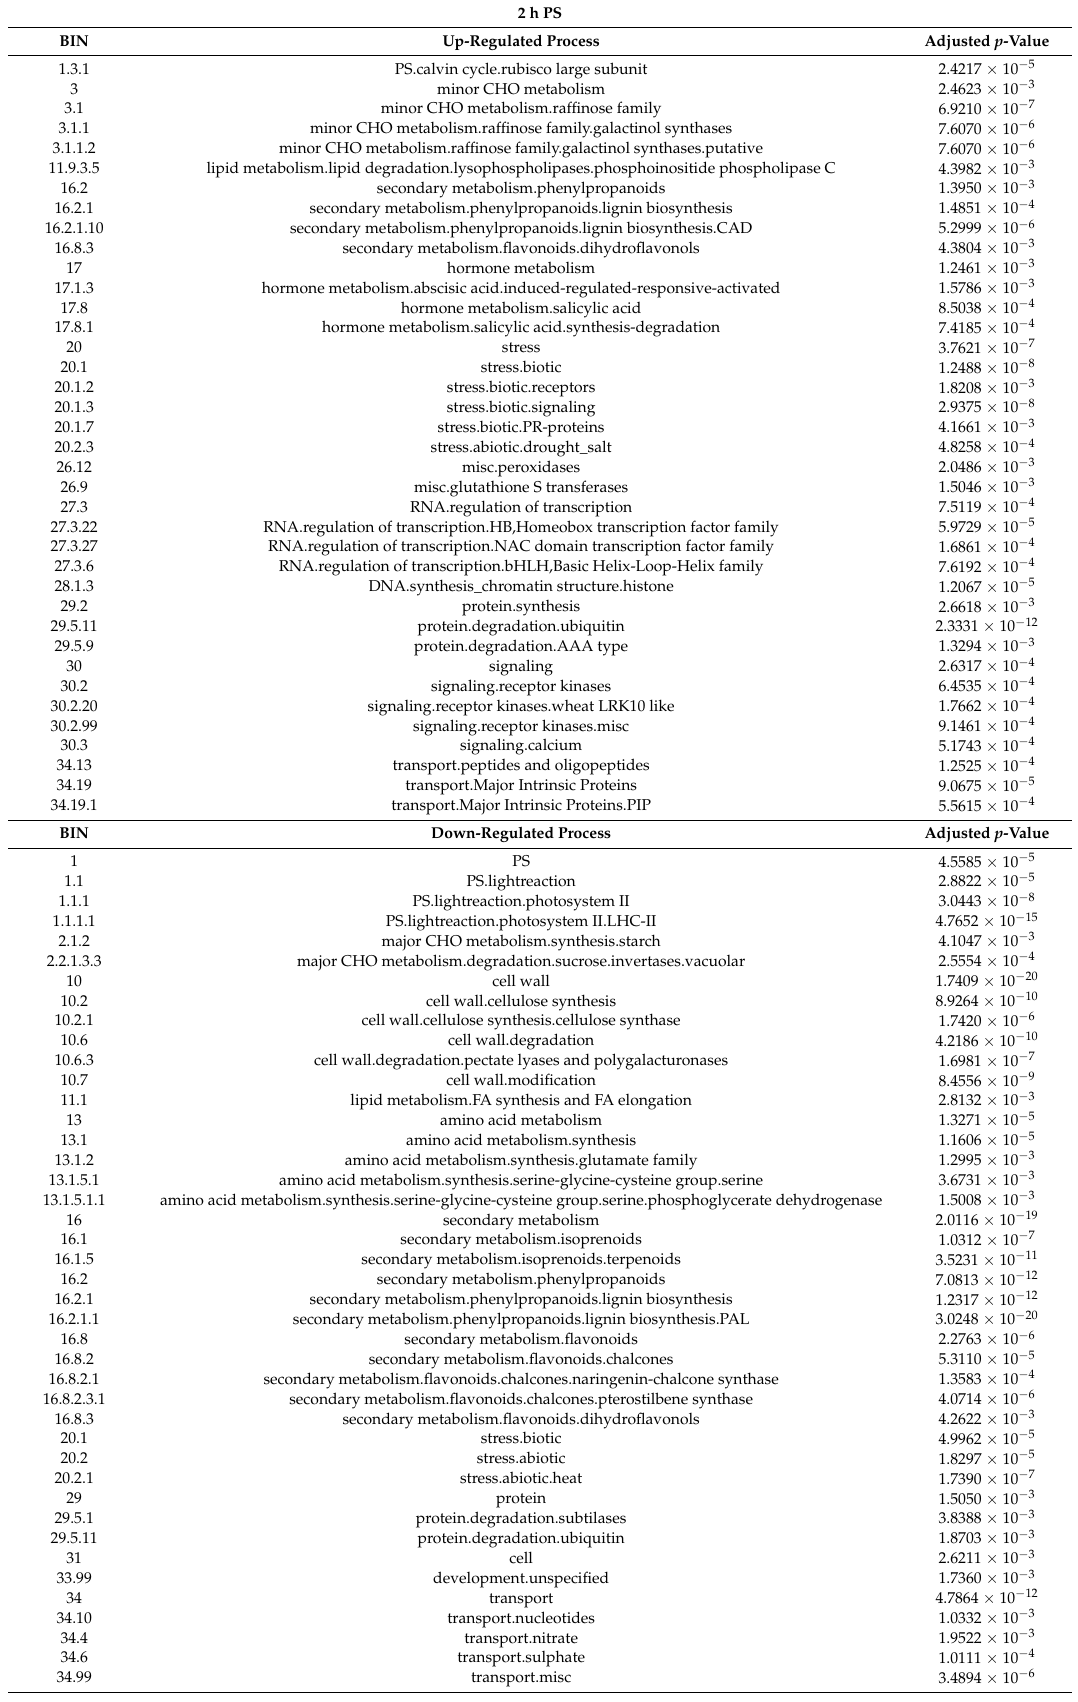
Table 2. Major functional categories highly impacted by the cold night at 2 h PS according to the Corto